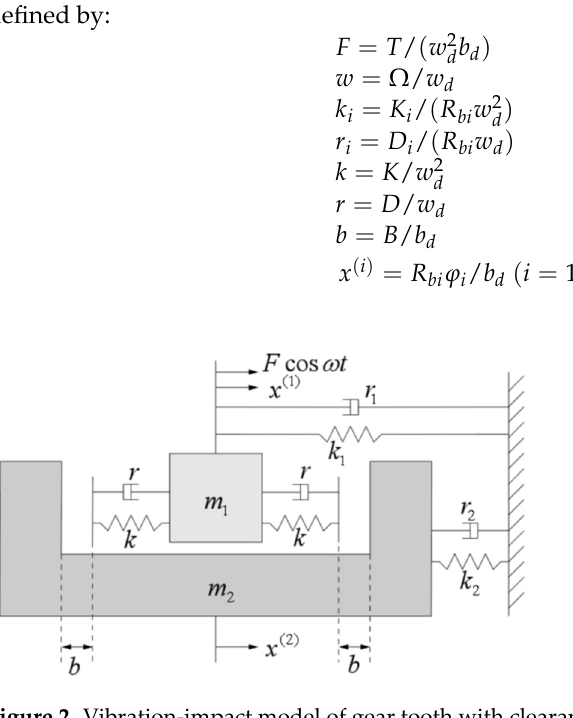
Figure 2. Vibration-impact model of gear tooth with clearance. Figure 2. Vibration‑impact model of gear tooth with